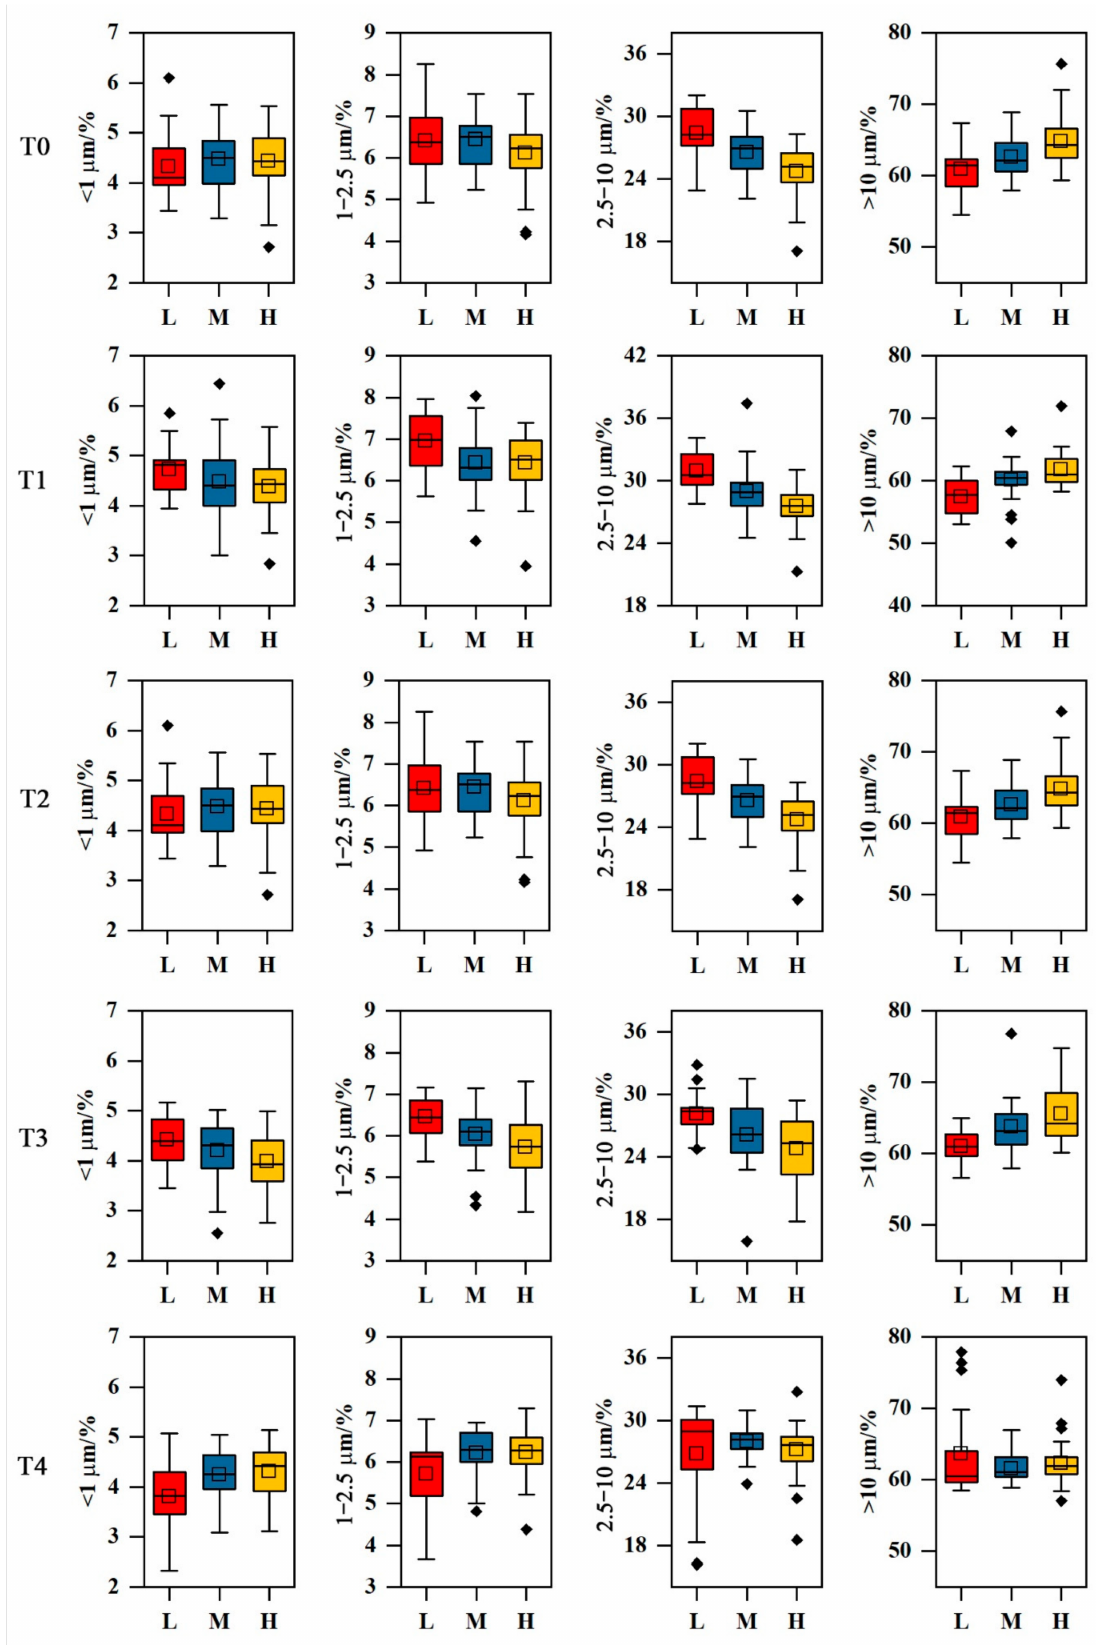
Figure 5. Box and whisker plots showing the percentage of different size fractions at different sampling height ranges (L, M, and H) for